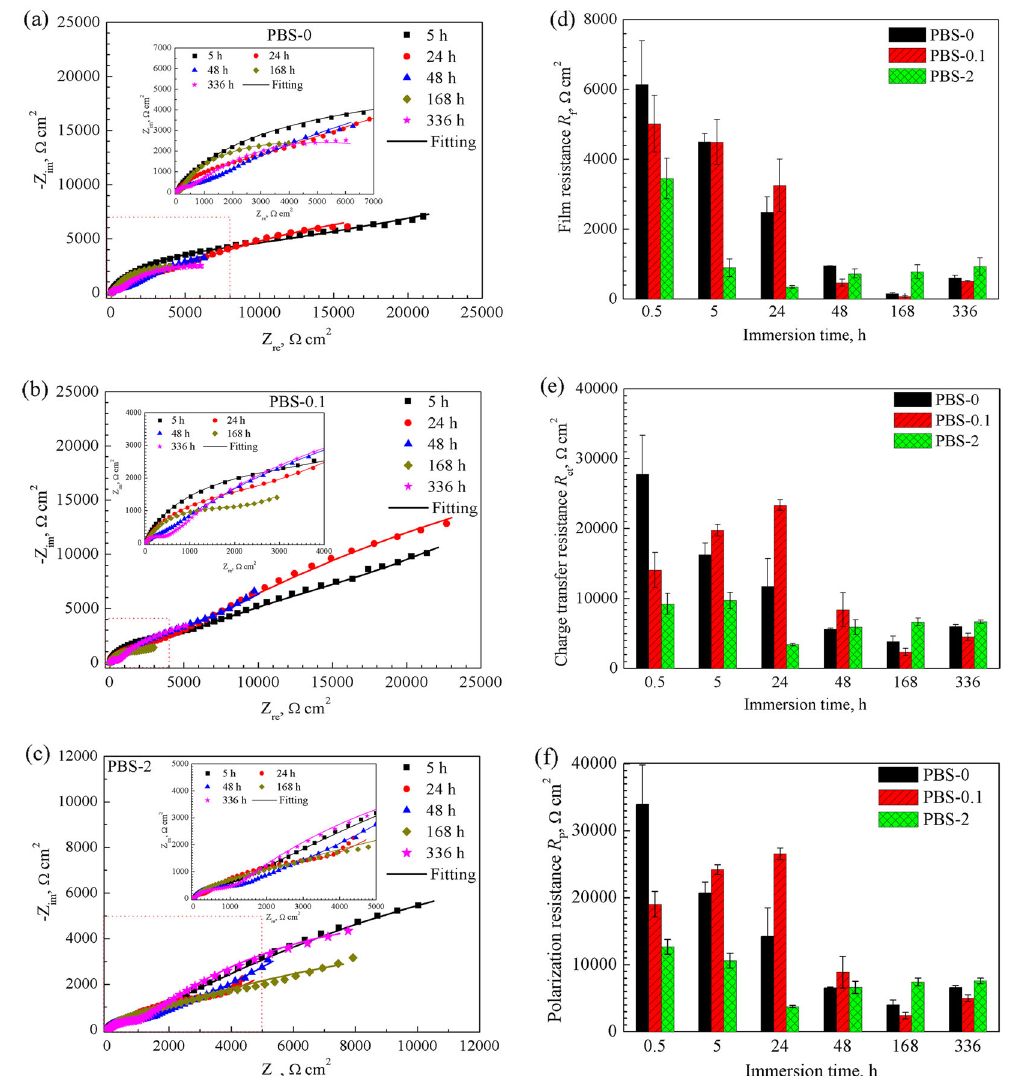
Fig. 2 Nyquist plots, a surface fi lm resistance R f , b charge transfer resistance R ct , and c total resistance R p of the pure Zn immersed in PBS-0, PBS- 0.1, PBS-2 for different duration. Insertion in a – c portrays the selected portion of the